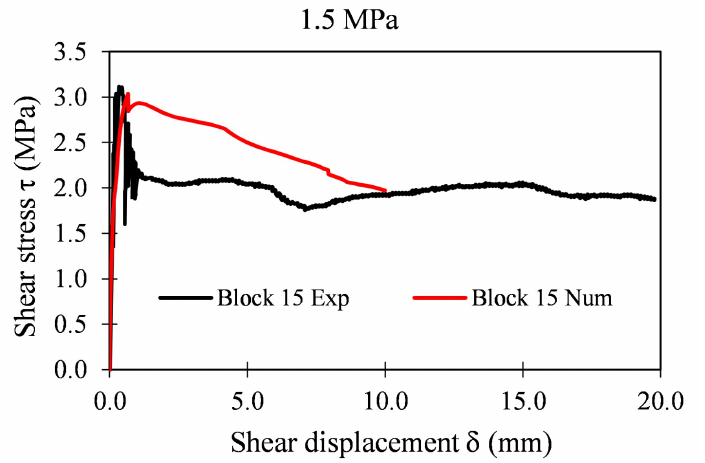
Figure 36. Shear stress evolution with displacement Exp–Num (Block